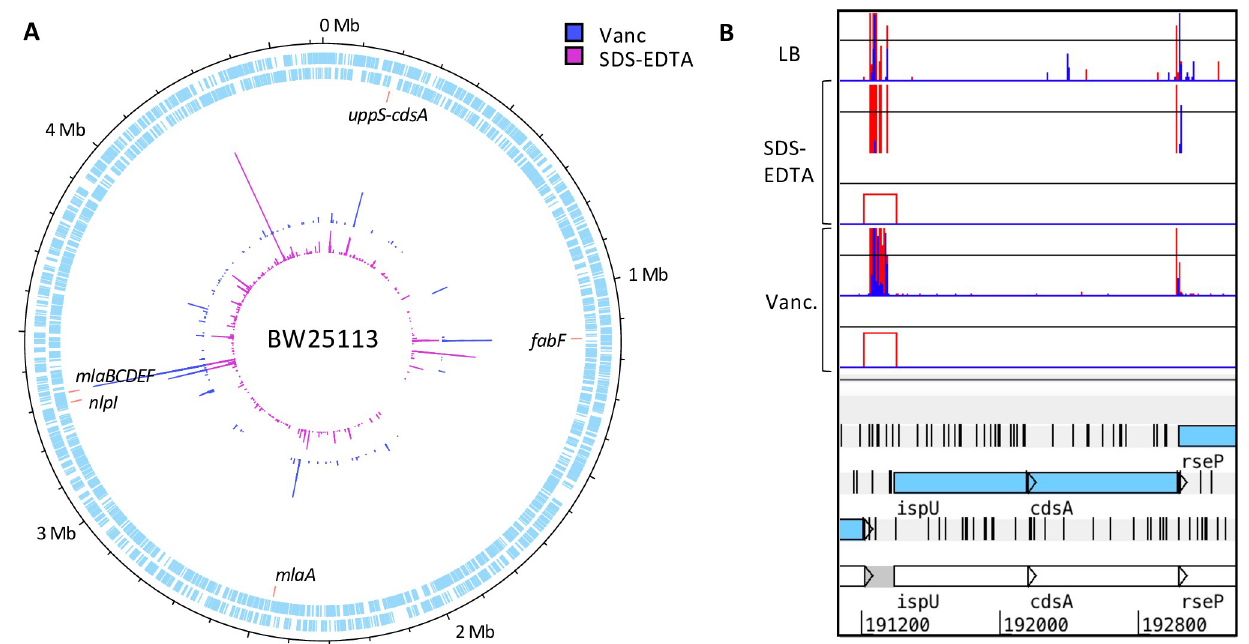
Fig 8. The uppS-cdsA operon. (A) Genome map showing the location and frequency of transposon insertion events that restore the viability of a yhcB mutant under toxic growth conditions: LB supplemented with vancomycin, or SDS and EDTA. (B) TIS data of the uppS (ispU) and cdsA operon. (Note that uppS is annotated as ispU in the BW25113 reference genome). Red and blue data correspond with the transposon orientation at the point of insertion; equivalent to sense and anti-sense directionality of the transcriptional read-out from the internal Tn promoter respectively. The height of the bar corresponds with mapped sequencing read frequency, capped at 20 in these images. The red boxes underneath each suppressor dataset represent significant differential abundance of insertions of the condition compared to the control, identified by AlbaTraDIS.